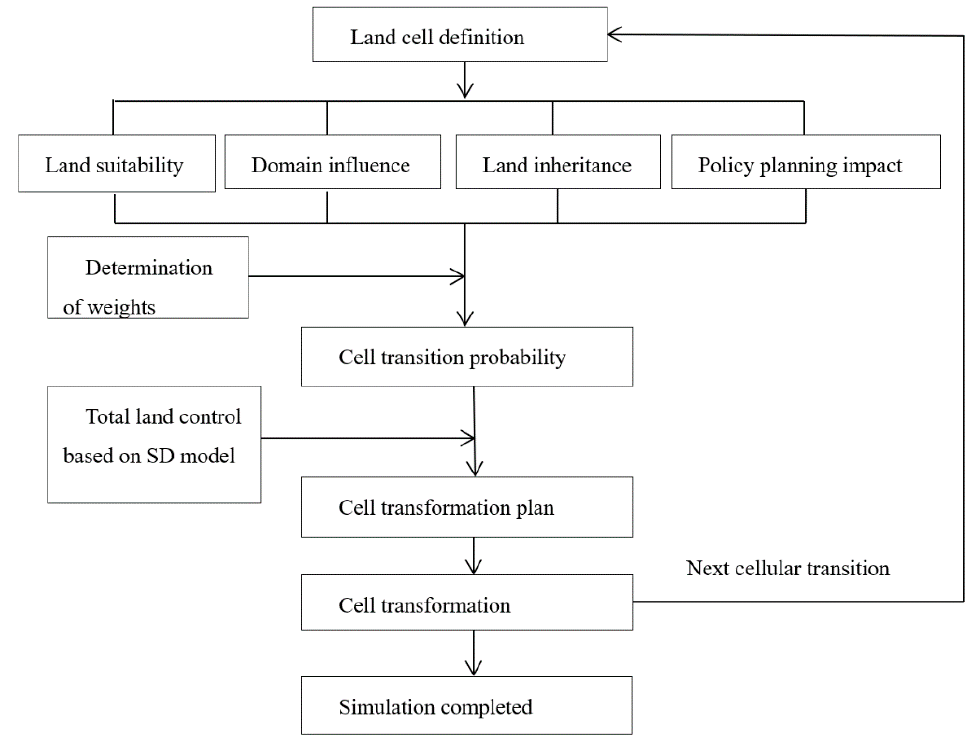
Figure 4. The Framework Developed for the CA Modeling